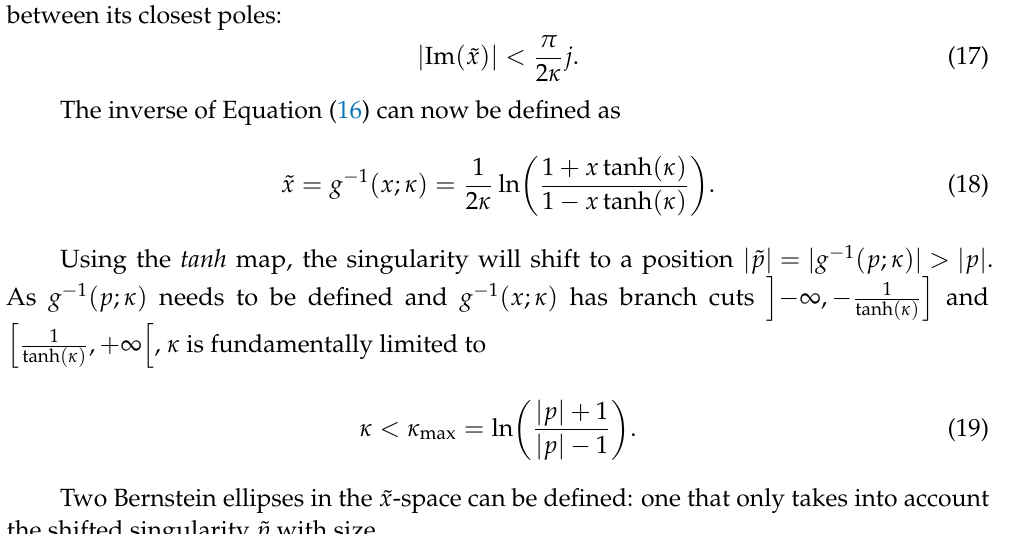
Figure 3. The tanh map for real ˜ x at different values of κ , together with the trivial map g ( ˜ x ) = ˜ x . The tanh ( z ) function is periodic with period π j , i.e., tanh ( z ) = tanh ( z Z . As the map needs to be bijective in order to define j π jl , with l simple poles at π 2 ± ∈ the inverse map, the domain of the above map is restricted to the strip around the real